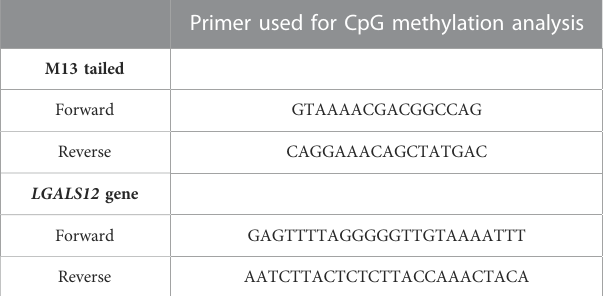
TABLE 3 Pro fi le of primer used for CpG methylation analysis (used in BGS). Primer used for CpG methylation